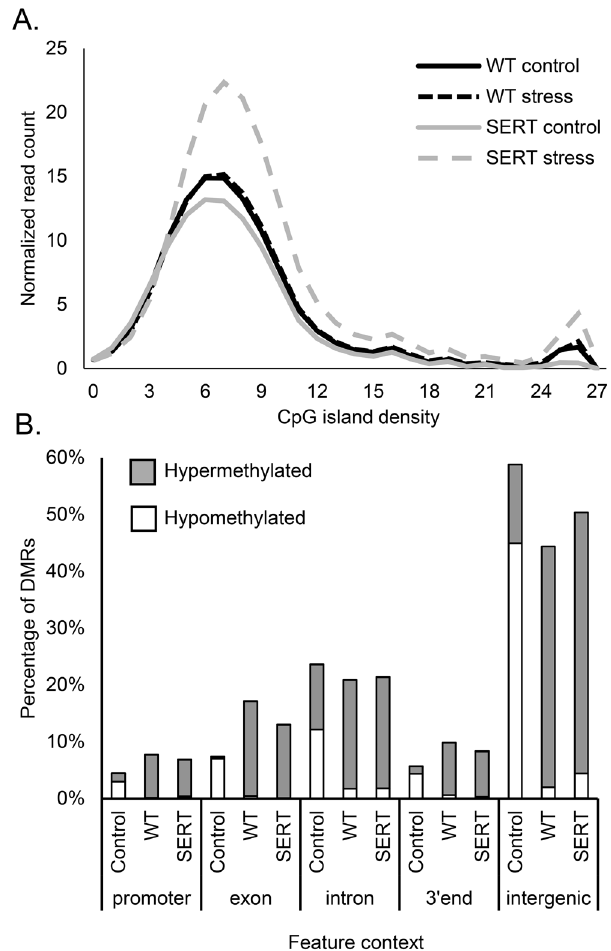
Figure 1. Embryo’s methylation profile is impacted by maternal effect. ( A ) The global methylation index quantifies genome wide methylation level for areas with similar CpG island density. SERT embryos exposed to prenatal stress display significant increase in genome methylation (one-way ANOVA F (3,6) = 5.92, p = 0.032 followed by Tukey post-hoc test p = 0.038). ( B ) Gene annotation links the genomic ranges containing differentially methylated regions (DMRs) to the gene model contexts. Control: the difference between maternal Slc6a4 + / − (SERT) embryos and wild-type (WT) embryos without stress, WT: the effect of stress on the WT embryos, and SERT: the effect of stress on SERT